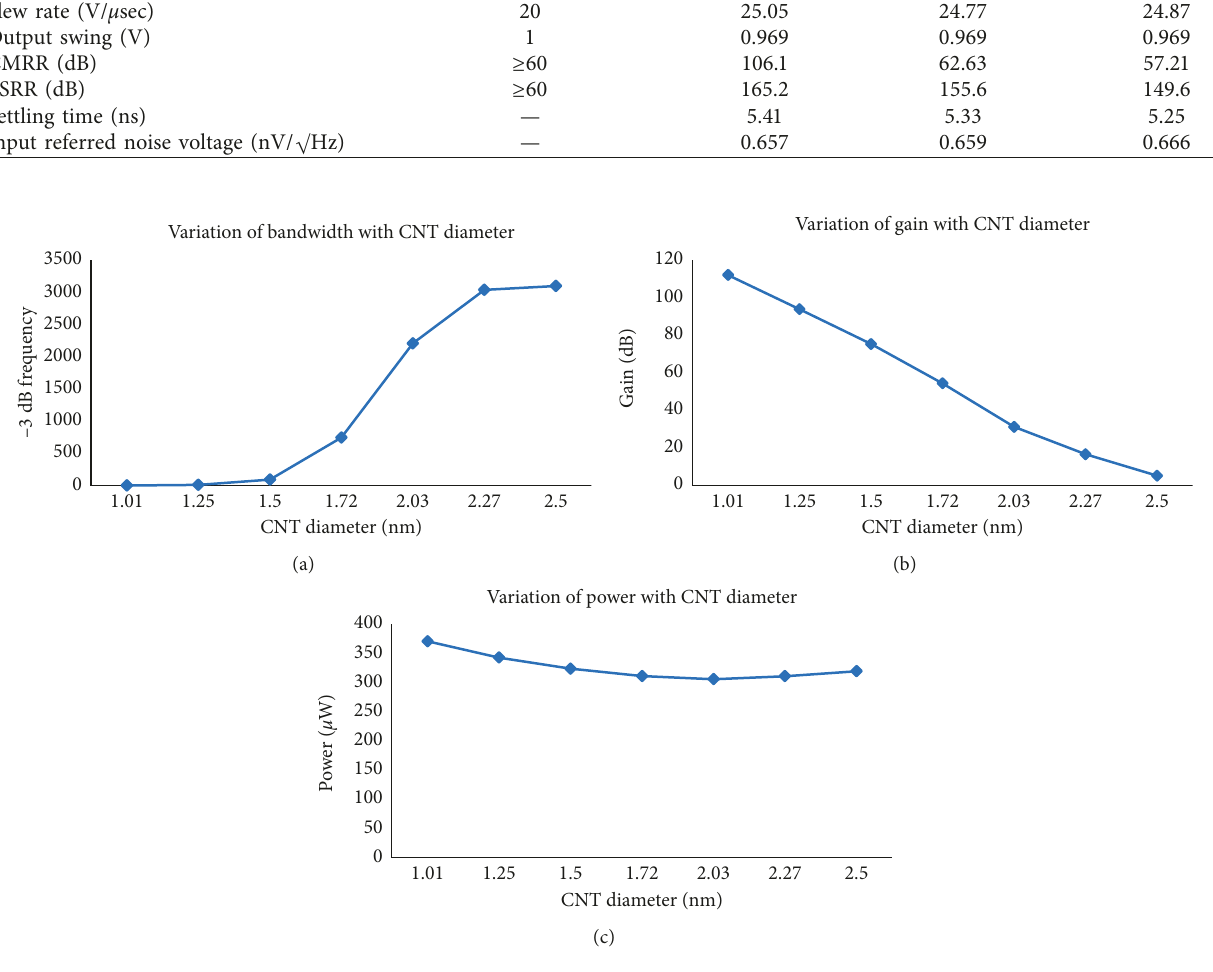
Figure 4: Effect of diameter variation on frequency response and power. (a) Frequency response (bandwidth). (b) Frequency response (open loop gain). (c)